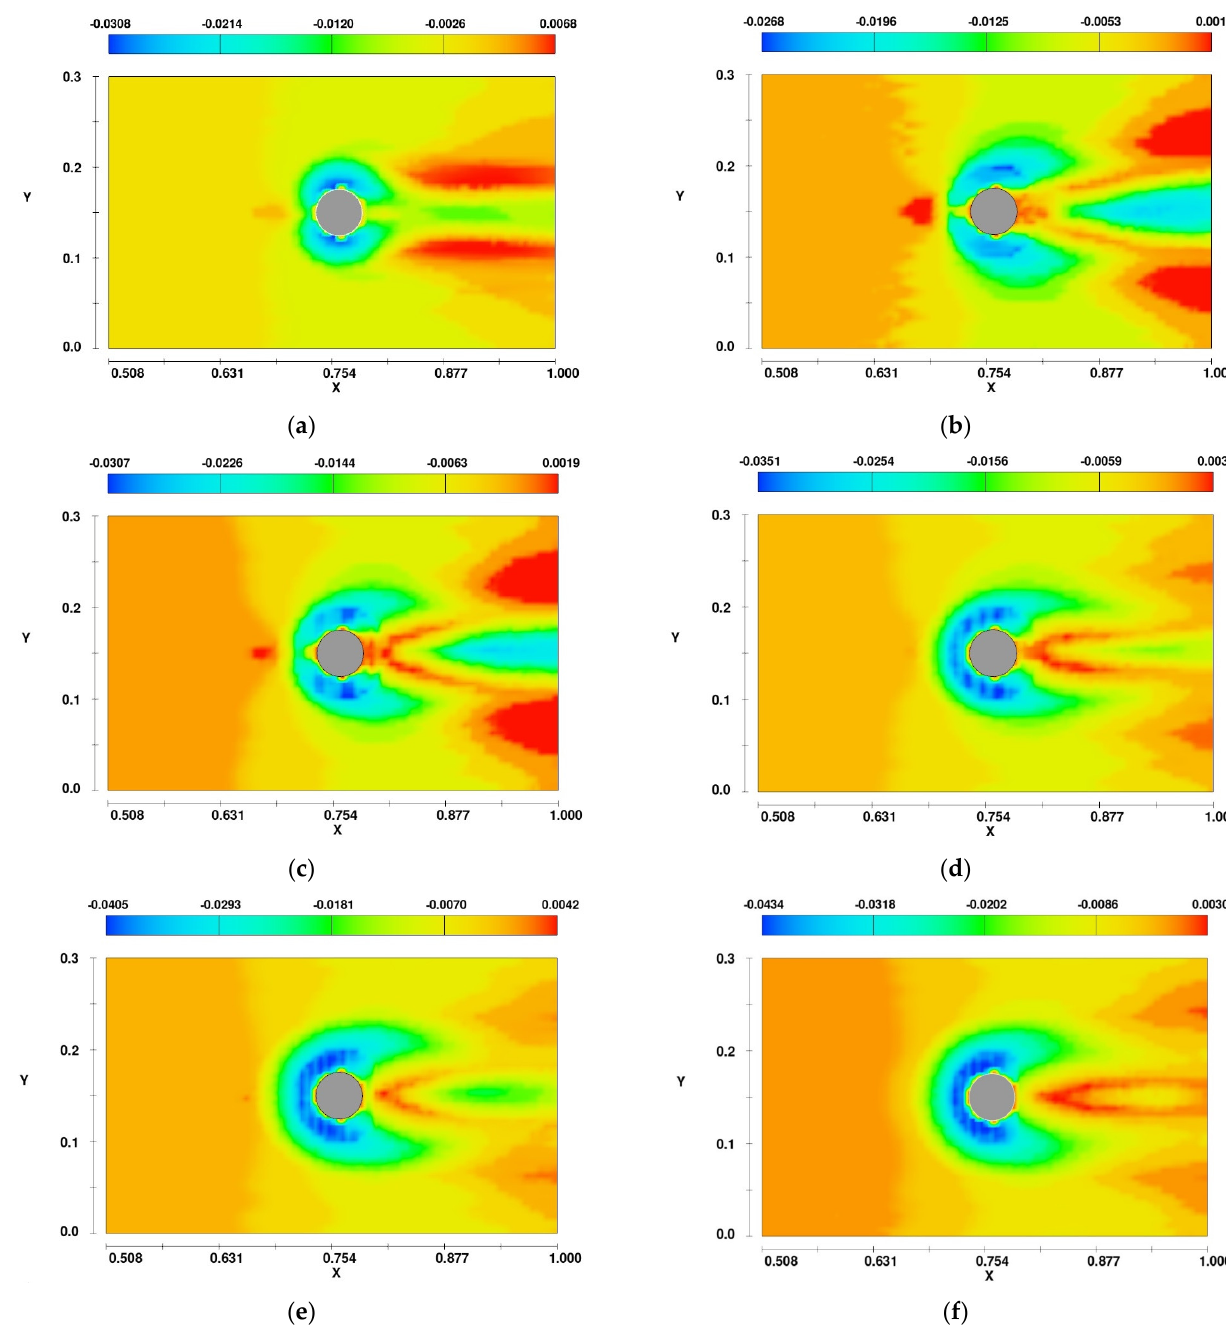
Figure 11. The top view of the topography in each case at t = 400 s (unit: m). ( a ) Case 1 (without circular collar). ( b ) Case 2 (θ = 0°). ( c ) Case 3 (θ = 5°). ( d ) Case 4 (θ = 10°). ( e ) Case 5 (θ = 15°). ( f ) Case 6 (θ = 20°).